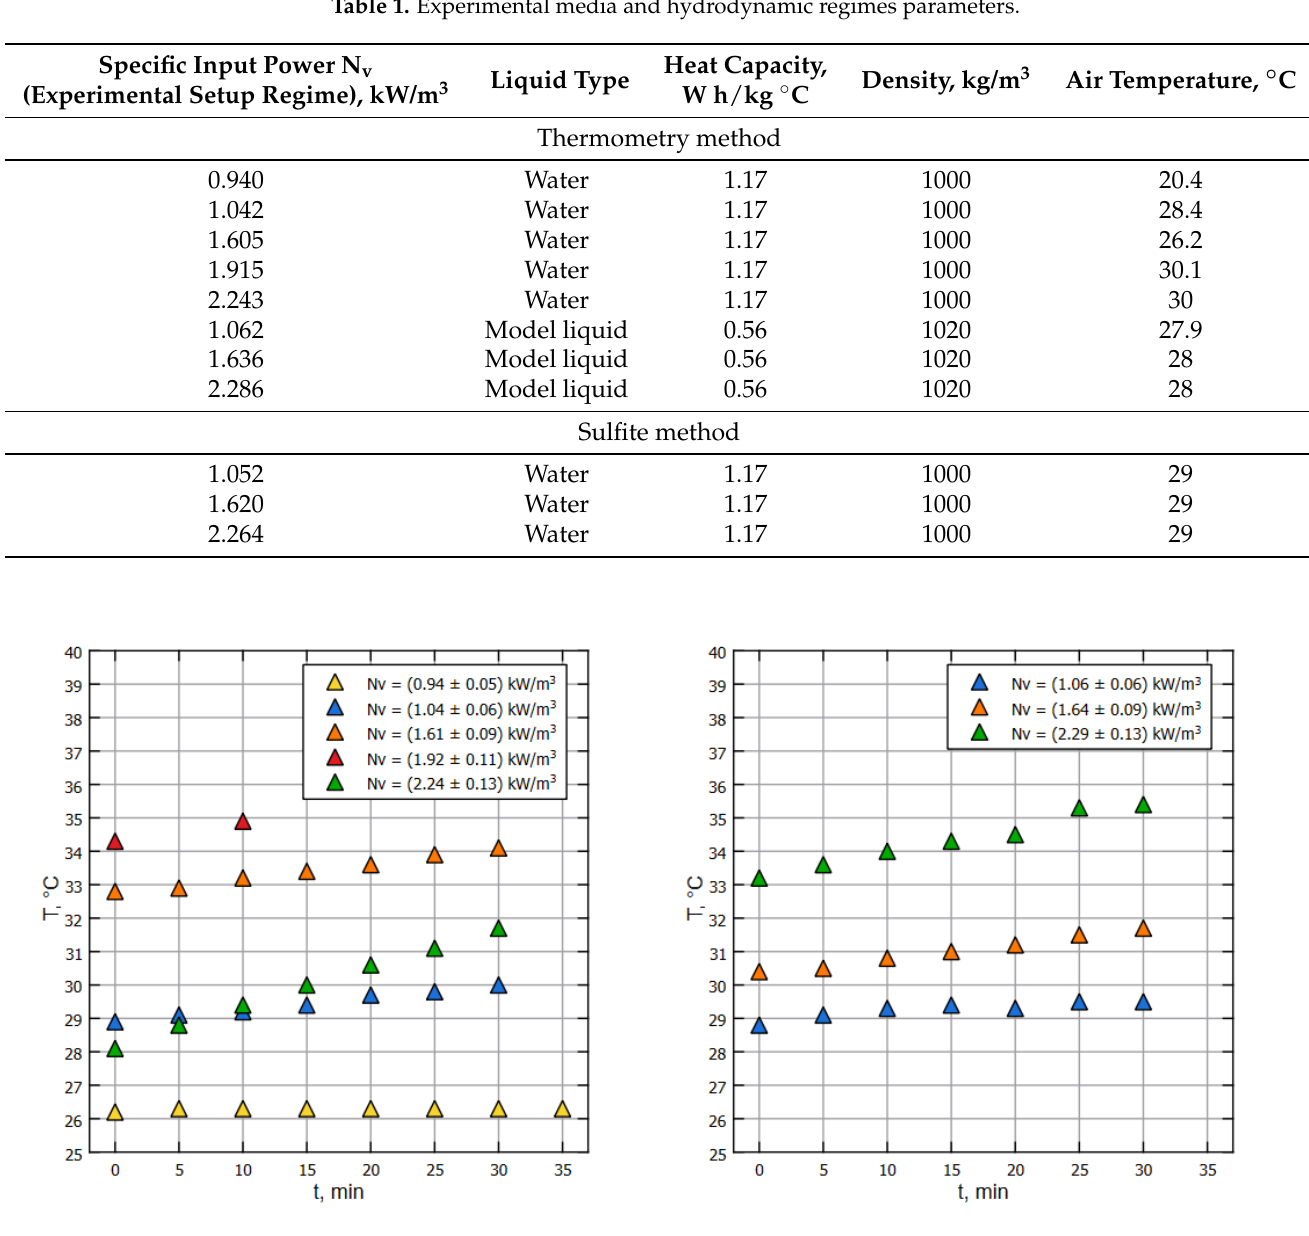
Figure 2. Relative temperature of the liquid changes with time, thermometry method applied on water ( left ) and model liquid ( right